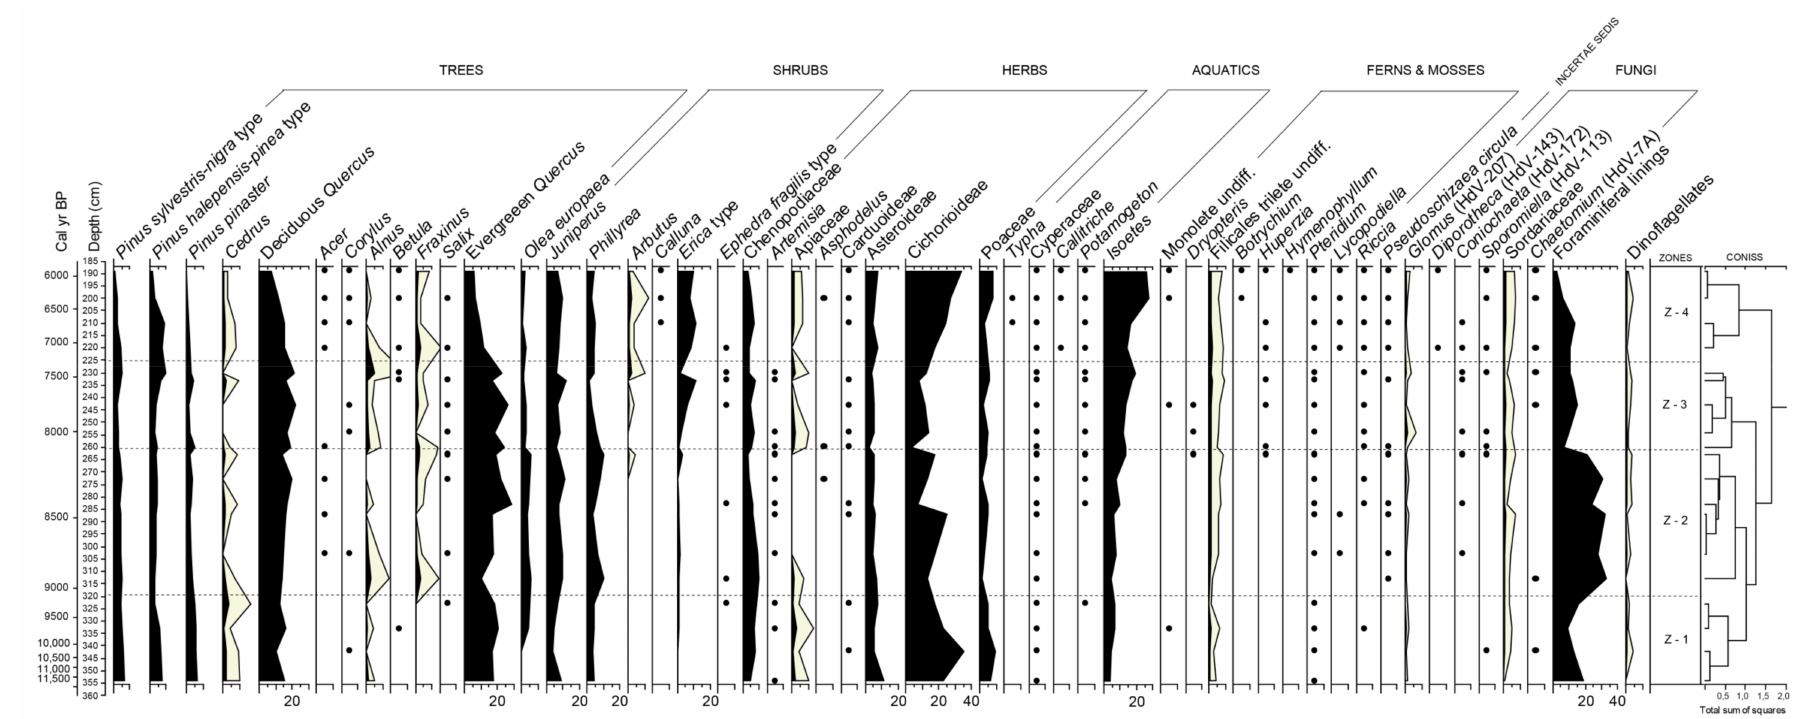
Figure 5. Pollen diagram for the core 19-01 showing trees, shrubs, herbs, aquatics, ferns and mosses, fungi, foraminiferal linings, and dinoflagellates with CONISS zonation vs. depth and